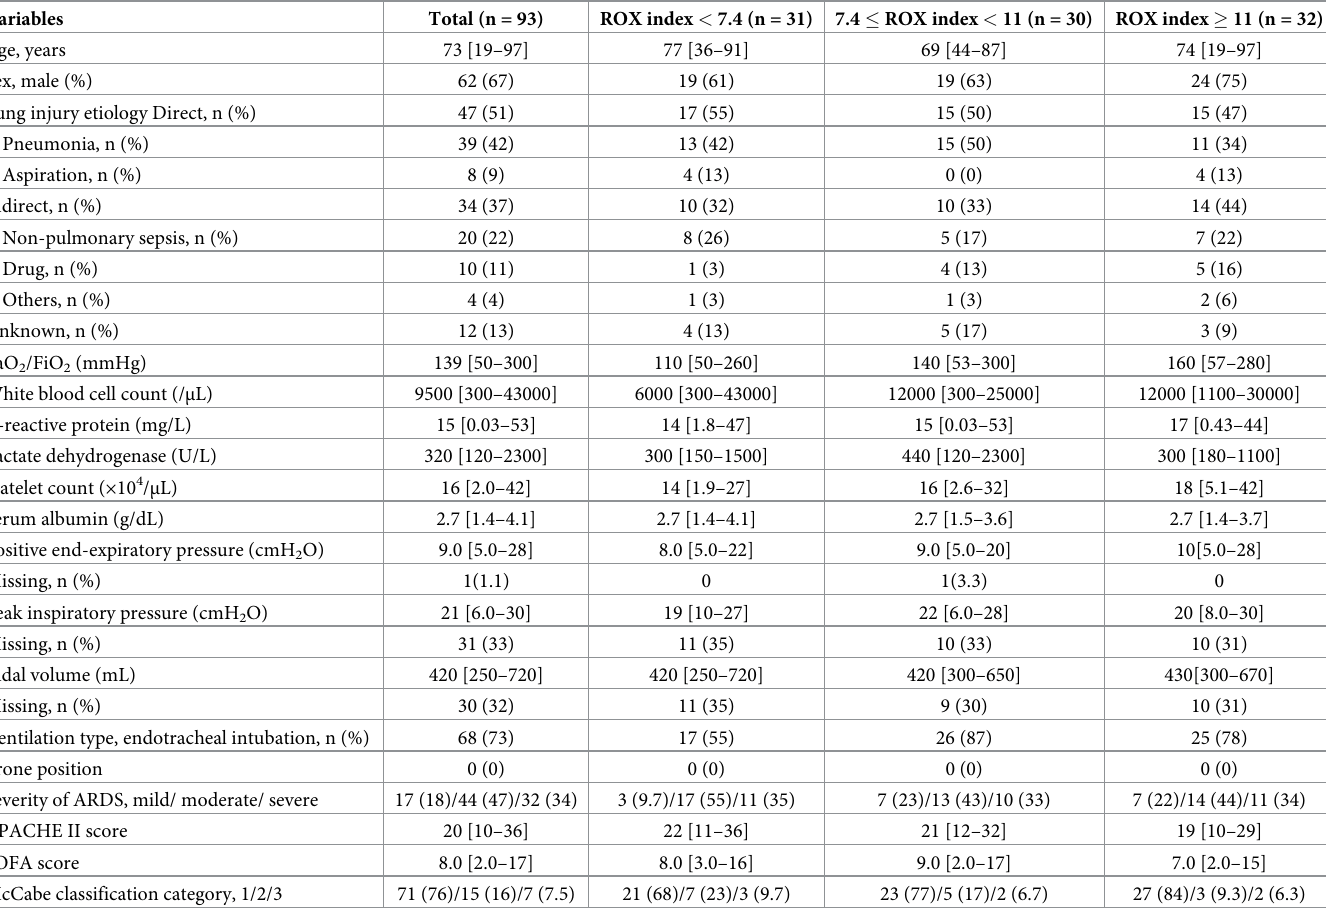
Table 1. Baseline characteristics of the enrolled